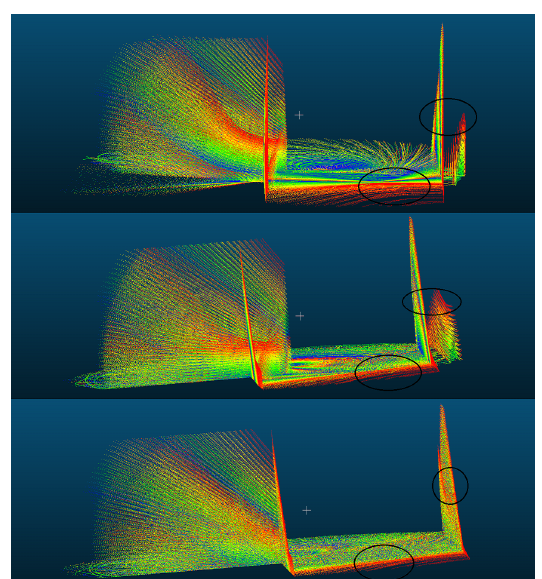
Table 6: Precision of the parameters found for the simulated data